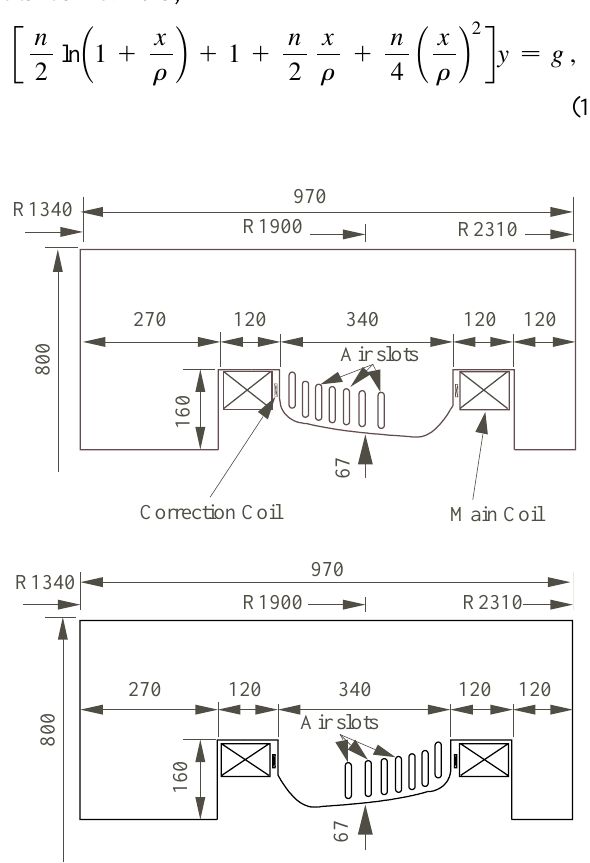
FIG. 2. Schematics of F and D sector poles.